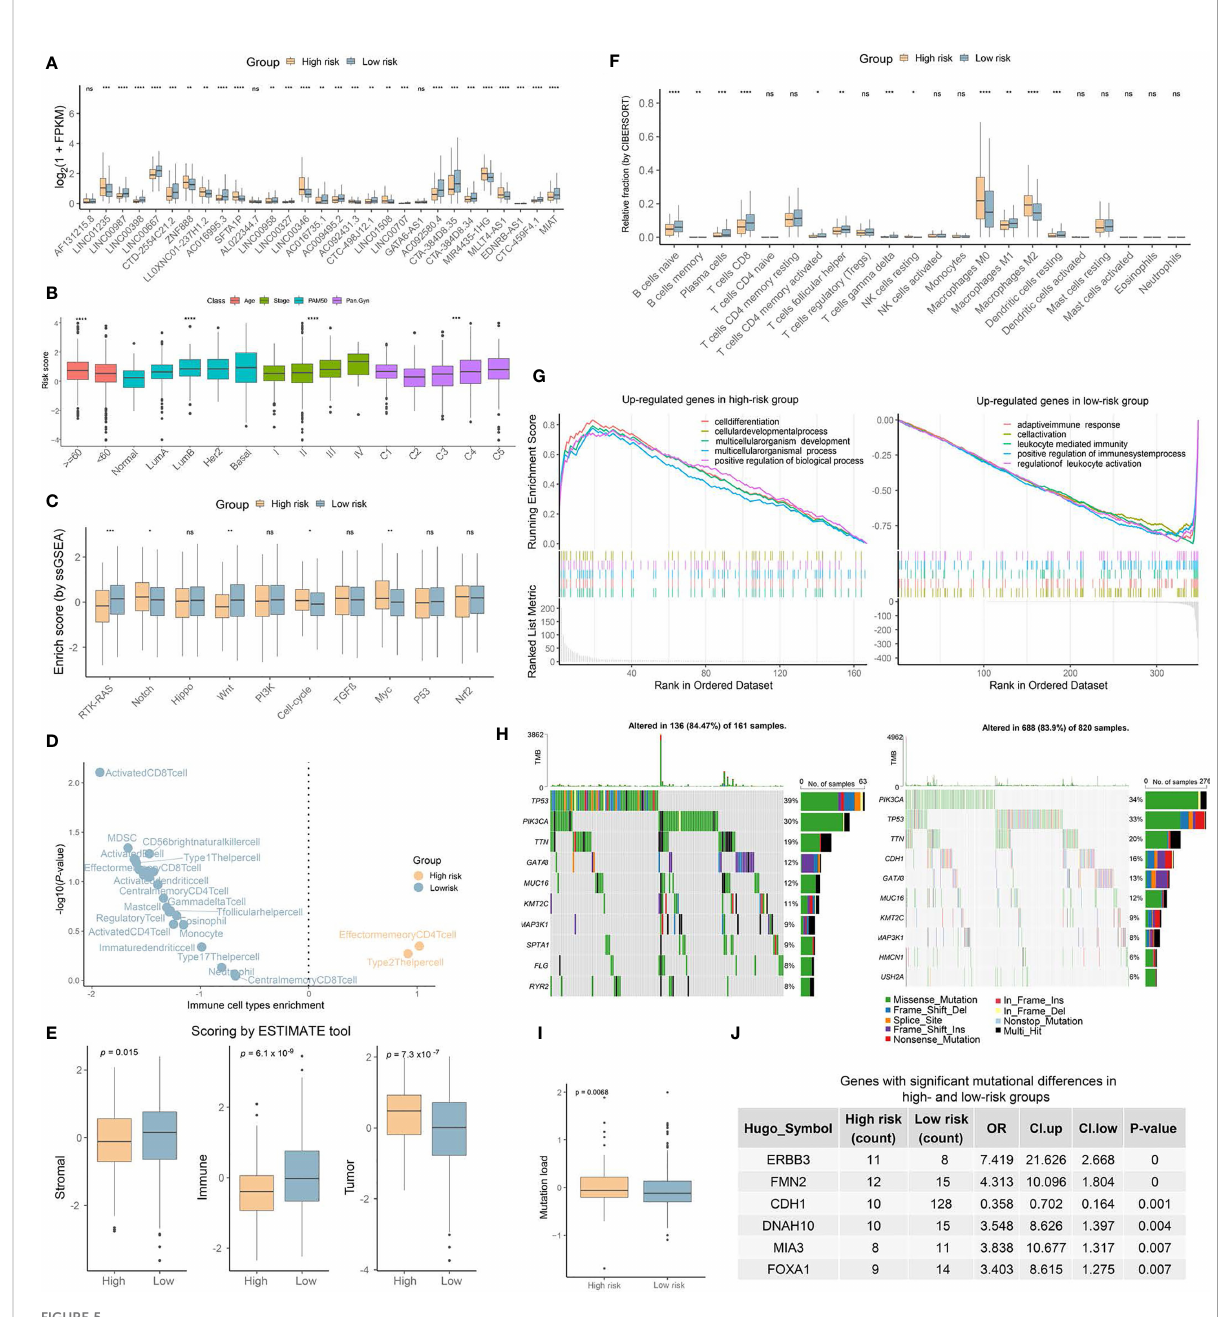
FIGURE 5 Clinical and biological characteristics of strati fi cation results of the OncoSig. (A) Box plot showing the statistical difference of the 29 lncRNA expressions between high- and low-risk groups. (B) Clinical characteristics of the risk score obtained on a strati fi ed analysis of the TCGA-BRCA cohort. (C) Box plot showing the statistical difference in the ES of the oncogenic signaling pathways between high- and low-risk groups. (D) Volcano plot for the enrichment of immune cell types in tumors with high and low OncoSig scores, calculated based on the normalized enrichment score from the gene set enrichment analysis (GSEA). (E) Stromal, immune, and tumor scores from the ESTIMATE tool for the high- and low-risk groups. (F) CIBERSORT predictions of the in fi ltration levels of 22 immune cells in the low- and high-risk groups. The dots represent the immune cell – scaled expression values. (G) GSEA showing signi fi cantly enriched GO terms in low- and high-risk groups, respectively. (H) The tumor mutational burden difference between the low- and high-risk groups. (I) Comparison of the relative distribution of the mutation load between the low- and high-risk groups in the TCGA-BRCA cohort. (J) Table showing the signi fi cantly mutated genes between the low- and high-risk groups. Only genes with more than 10 mutations were included in the Fisher ’ s exact test analysis. Notably, ns: not signi fi cant, * p ≤ 0.05, ** p ≤ 0.01, *** p ≤ 0.001, **** p ≤ 0.0001. The Wilcoxon rank-sum test was used for the statistical